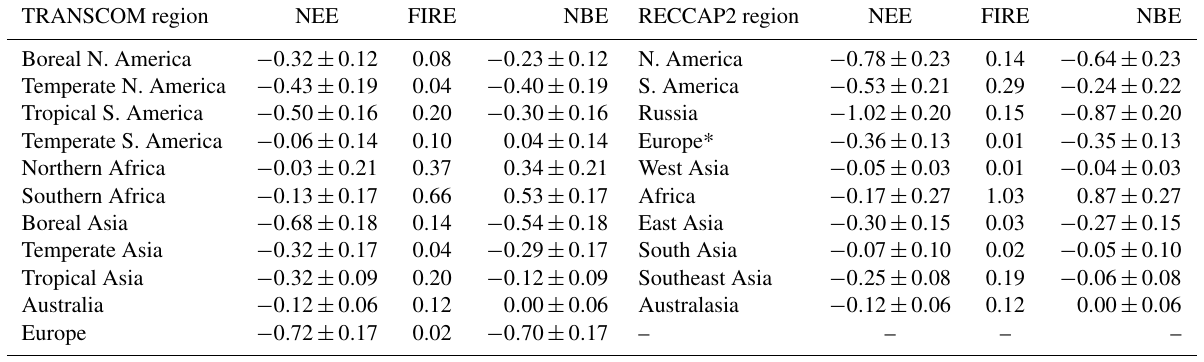
Table 2. Regional terrestrial ecosystem carbon flux (PgCyr − 1 ).